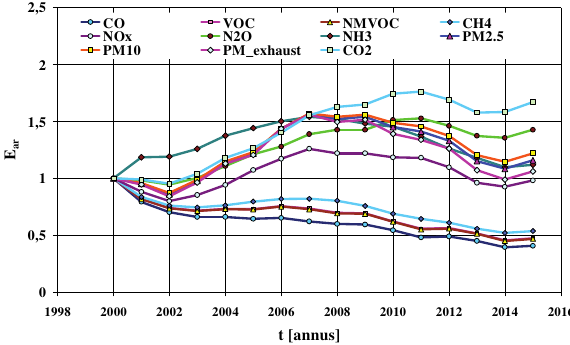
Fig. 19. Relative national annual emission of individual pollutants In figure 20, there is presented the relative national annual emission of individual pollutants from one conventional motor vehicle, versus the national annual emission in 2000.